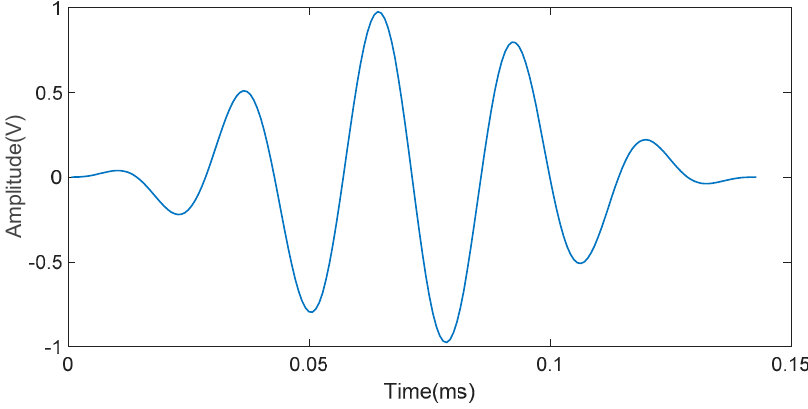
Figure 6. Excitation nodes of modes. ( a ) Excitation node of mode 1; ( b ) excitation nodes of mode 3; ( c ) excitation nodes of mode